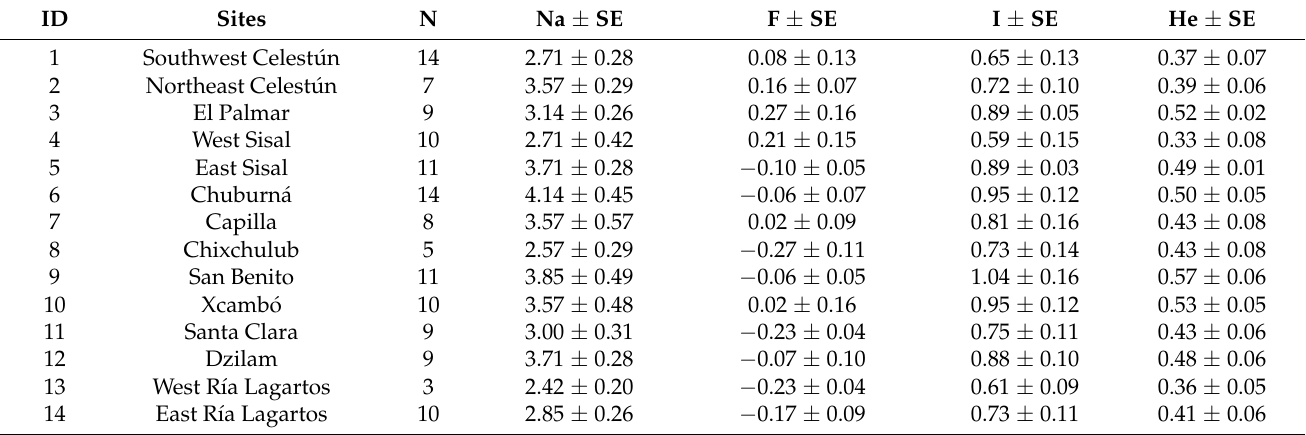
Table 1. C. yucatanicus genetic variability in 14 sampled sites in the northern Yucatan Peninsula, Mexico. Sample size (N), allele richness (Na), inbreeding index (F), Shannon diversity index (I), expected heterozygosity (He), and standard error